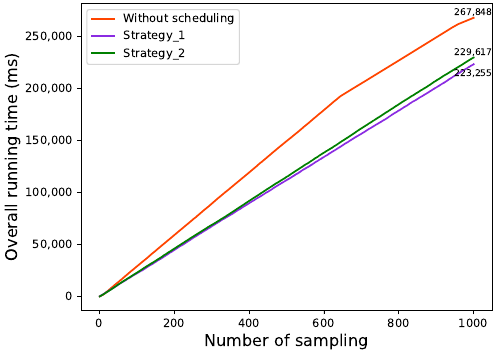
Figure 12. Comparison of overall running time under the three conditions.